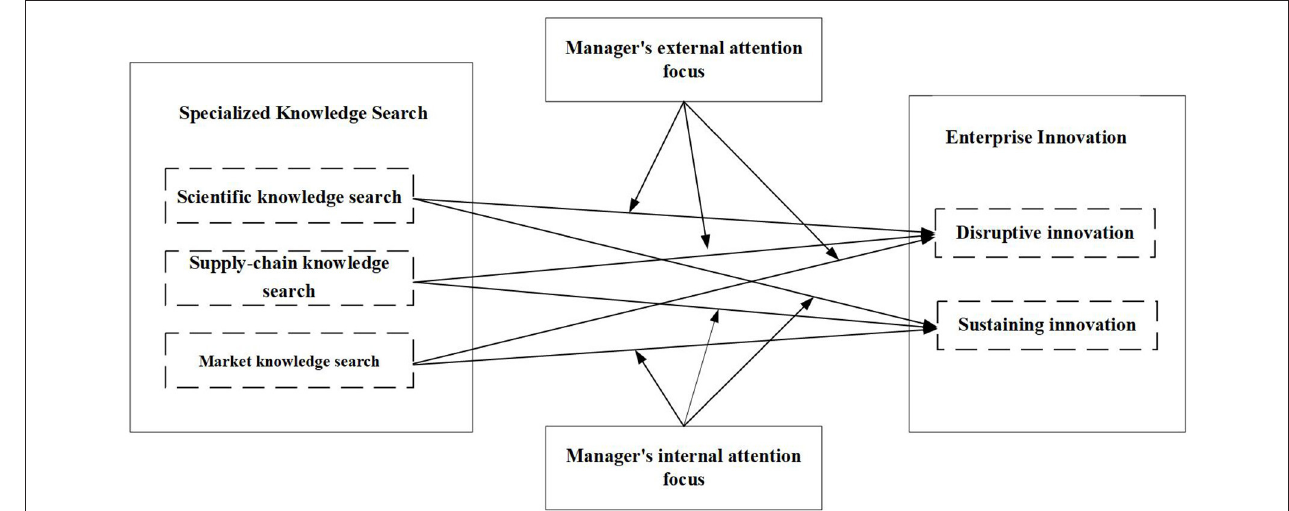
FIGURE 1 | Theoretical